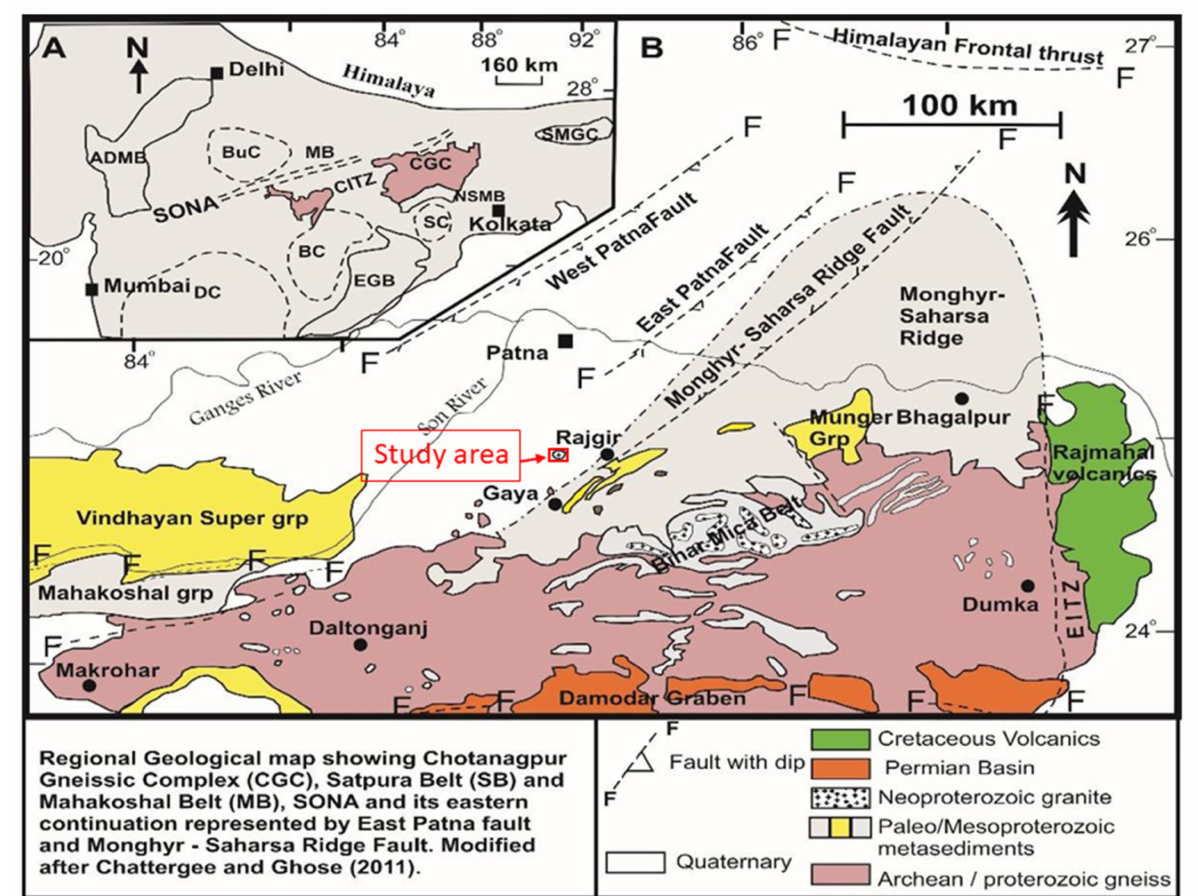
Figure 2. Geological map of the region depicting the study area (After [6] (Chatterjee & Ghose, 2011). The bulk of the CGC constitutes of late Precambrian gneisses and granites of at least three generations [7] and migmatites, in quartzite grading to ferruginous quartzite, oc- casionally grunerite bearing, phyllites and mica schists, grading into mica-gneiss due to granitization, calc-silicate rocks, limestones, ortho- and para-amphibolites, and skarn rocks occur as enclaves of varying dimensions. The rocks within the Complex have witnessed metamorphism from middle to upper amphibolite facies, the general P-T conditions being 4–6 Kb and about 680 ◦ C, respectively [8,9]. Within this, granulite-facies of rocks, con- sisting of khondalites, leptynites, charnockites, quartz-magnetite granulite etc., occurring in patches, were noted in Godda, Dumka, Bhagalpur, Palamau, and Ranchi districts of Bihar (Table 1). The CGGC is also characterized by the occurrence of various types of anorthosite-gabbro suite of rocks [10]. Anorthosite magmatism in CGGC, representing an end- product of differentiated basic igneous rocks, was found at Bela, Hizla, and Chatra (Figure